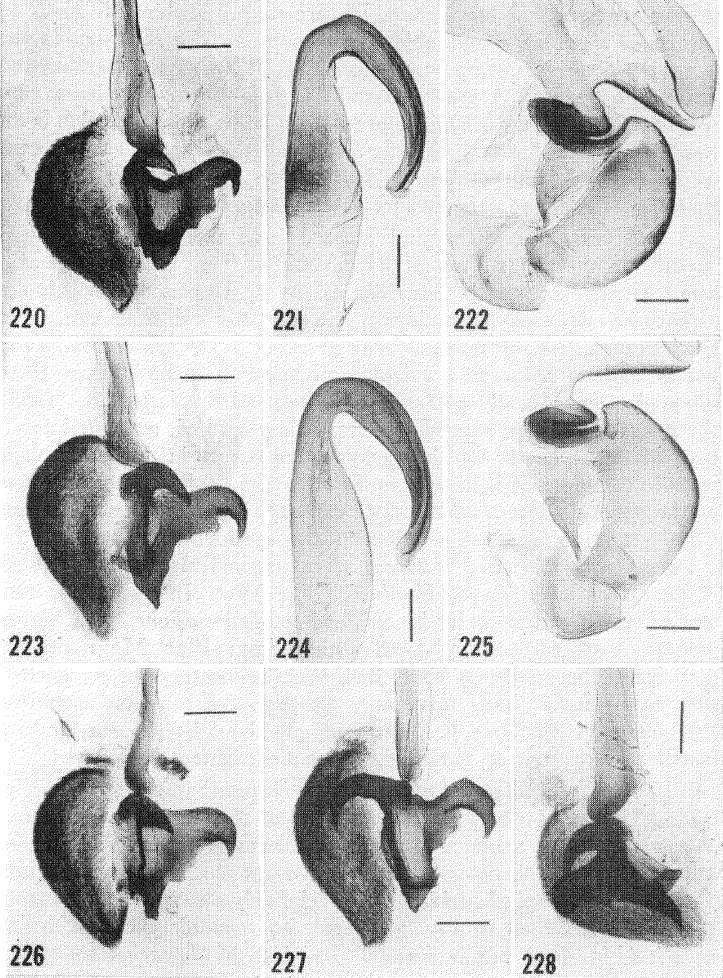
Figs. 220-228. Cockroach male genitalia. EI)ilamI)ra basistriza. 220-222. (78 USNM). Piraeieaba, So Paulo, Brazil (det. Gurney). 223-225. (104 USNM). Brazil (det. Albuquerque). 226. (114 USNM). South of So Paulo, Brazil. 227. (90 ANSP). Guaraja, Silo Paulo, Brazil (det. by Hebard as E. delicata Hebard, a synonym of basistriga). 228. (77 USNM). Same locality as figures 220-222; L2d is-turned on its side (det. Roth). (scale 0.2